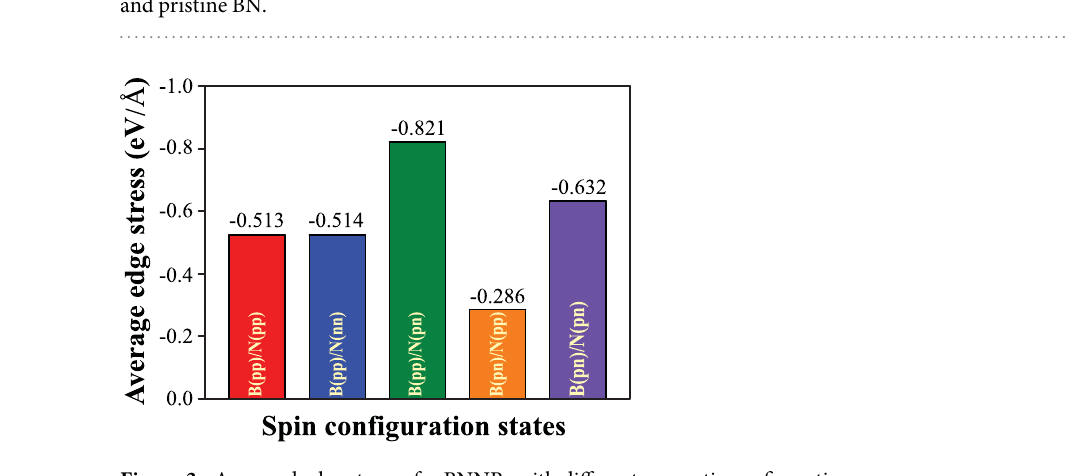
Figure 2. Variation in potential energy with applied strain for zzBNNRs with different magnetic configurations and pristine BN.